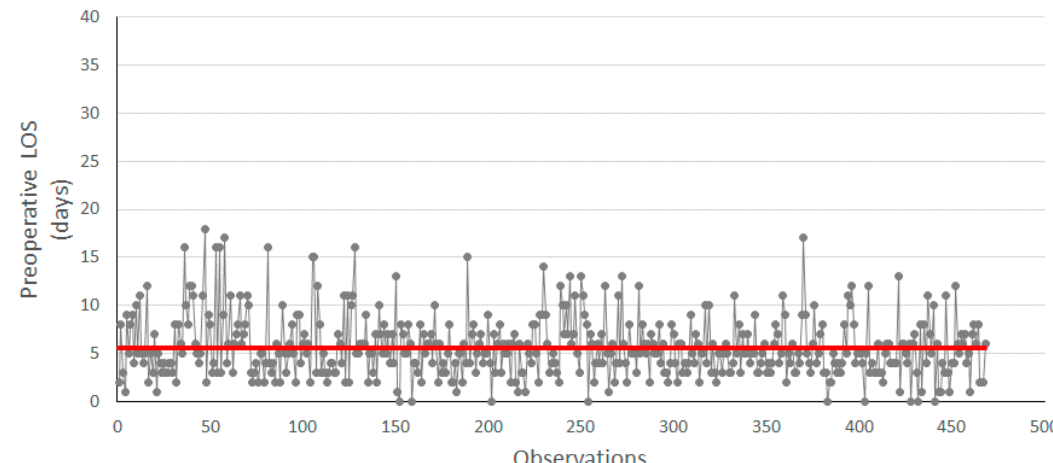
Figure 1. Run chart of preoperative LOS before improvement. The red line indicates the average value of 5.6.